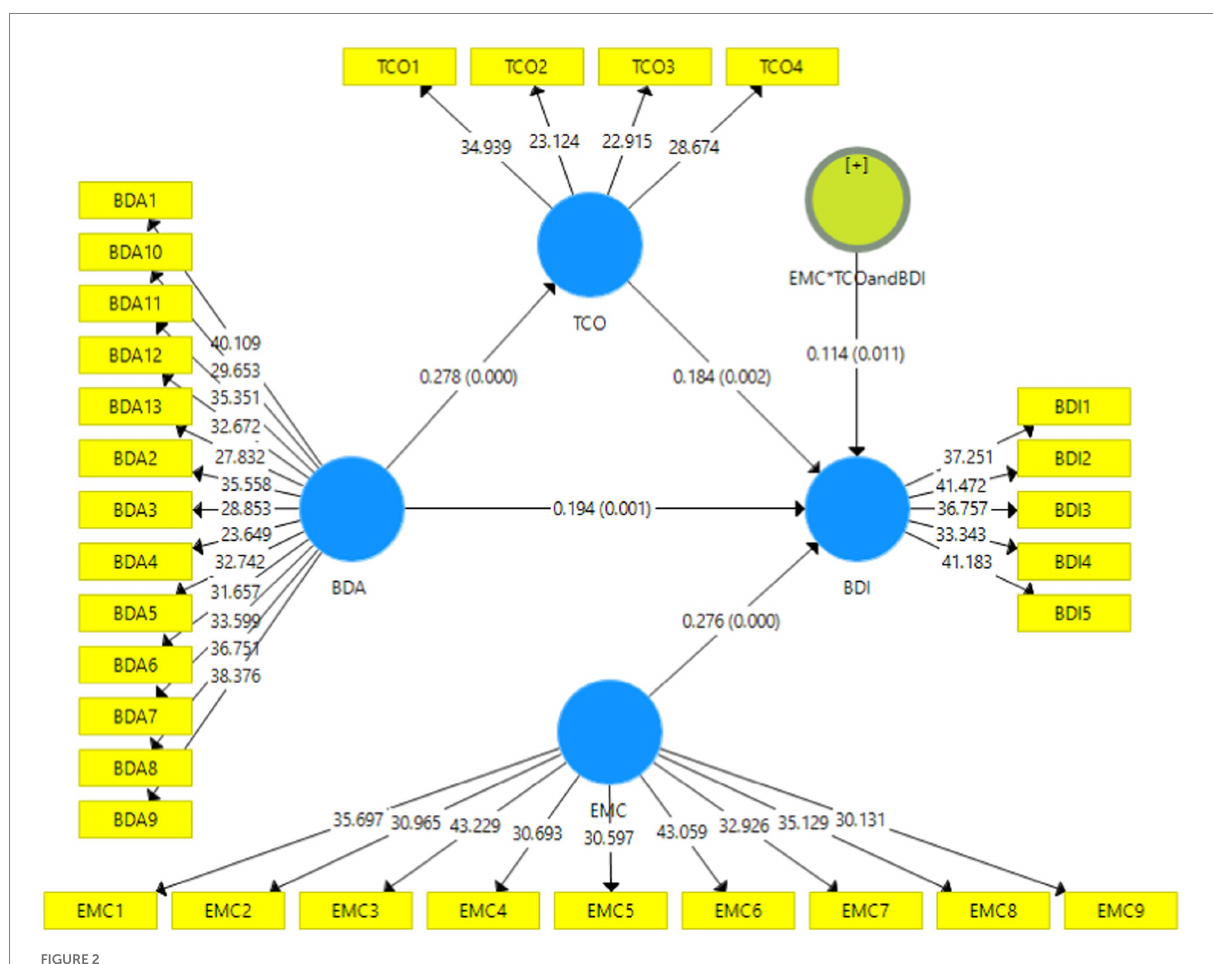
FIGURE 2 Structural model. BDA = big data analytic capabilities, TCO = technological orientation, EMC = employee creativity, and BDI = business model